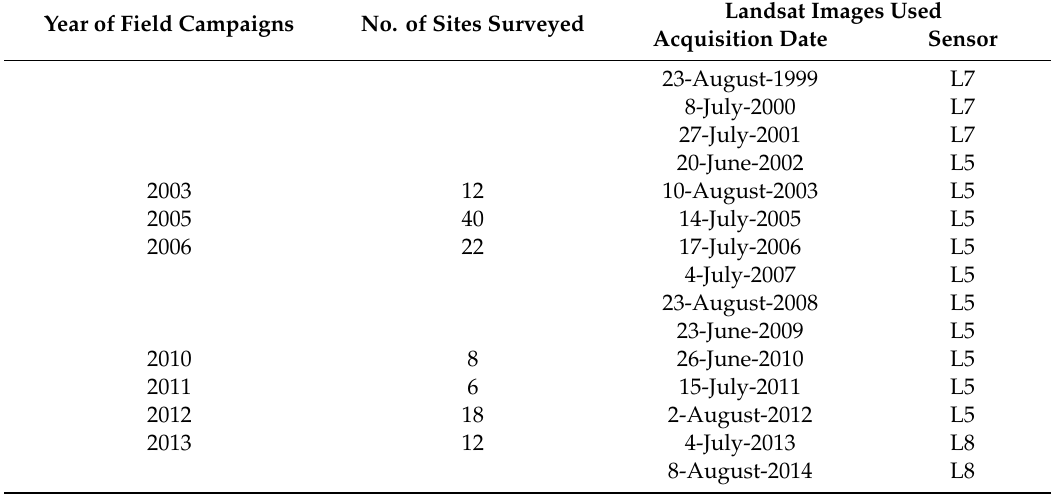
Table 1. Field campaigns, field sites, and Landsat images